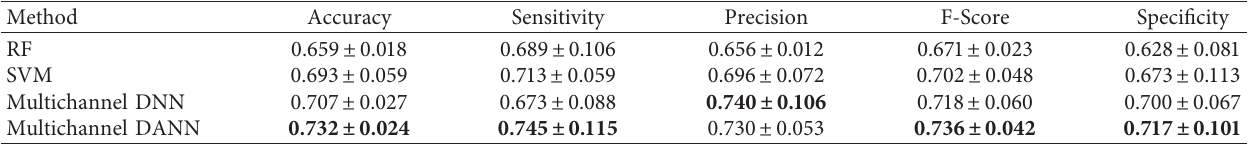
Table 2: Comparison of random forest (RF), support vector machine (SVM), multichannel deep neural network (DNN), and multichannel deep attention neural network (DANN) classifiers trained using 10-fold cross validation on the entire